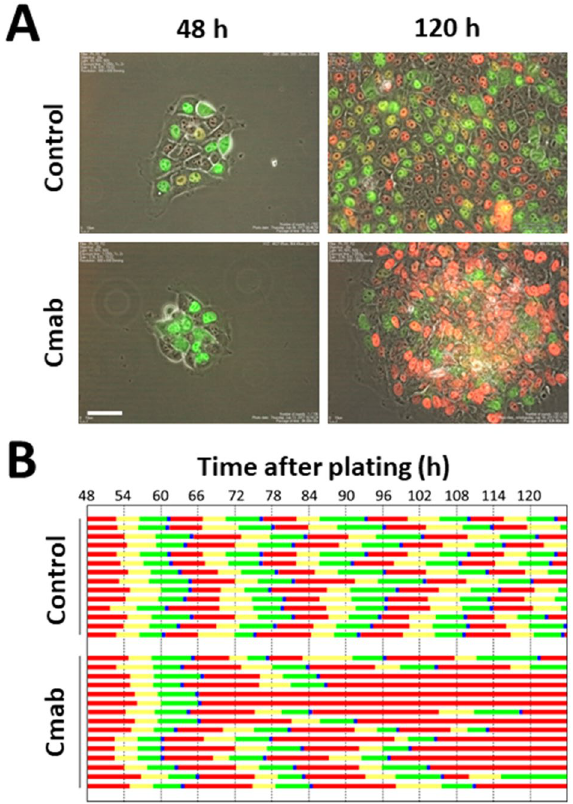
Figure 2. Time-lapse and pedigree analysis of control- and cetuximab-treated SAS-Fucci cells. (A) Cetuximab was administered to SAS-Fucci cells 48 h after they were plated in cell culture dishes. Time-lapse analysis using the Fucci system revealed that cells in G1 phase (red) gradually accumulated especially in the central regions of colonies after 120 h of treatment. In contrast, the control cells showed stable growth. (B) Pedigree assays revealed that, after treatment with cetuximab (10 µg/mL), the cells in the central regions of colonies gradually became arrested in G1 phase, whereas the control cells continued to divide once per ~ 20 h. Red, yellow, green, and blue bars represented G1, S, G2, and M phase, respectively. Scale bar, 50 µm.